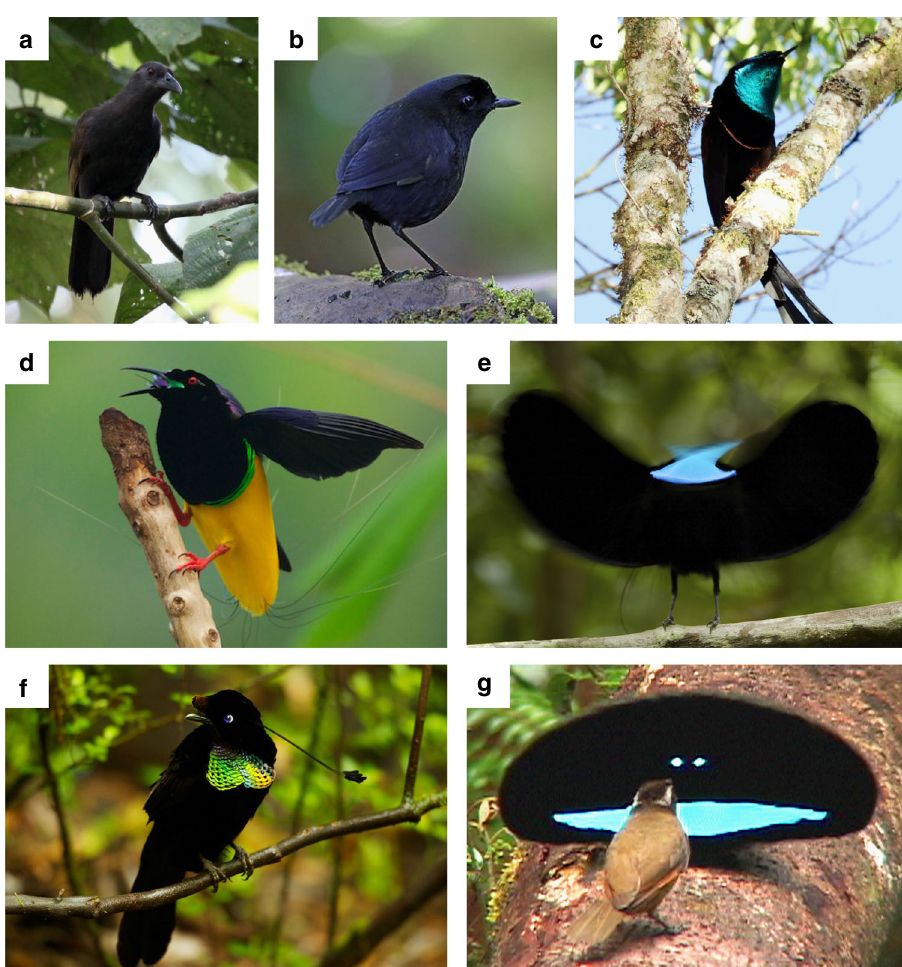
Fig. 1 Six species of birds of paradise and one close relative. a , b Species with normal black plumage patches. c – g Species with super black plumage patches. a Paradise-crow Lycocorax pyrrhopterus . b Lesser Melampitta Melampitta lugubris , a Papuan corvoid closely related to birds of paradise. c Princess Stephanie ’ s Astrapia Astrapia stephaniae . d Twelve-wired Birds-of-Paradise Seleucidis melanoleucus . e Paradise Ri fl ebird Ptiloris paradiseus during courtship display. f Wahnes ’ Parotia Parotia wahnesi . g Superb Bird-of-Paradise Lophorina superba during courtship display with female (brown plumage). Photo credits: a @Hanom Bashari/Burung Indonesia; b Daniel López-Velasco; c Trans Niugini Tours; d – f Tim Laman; g Ed